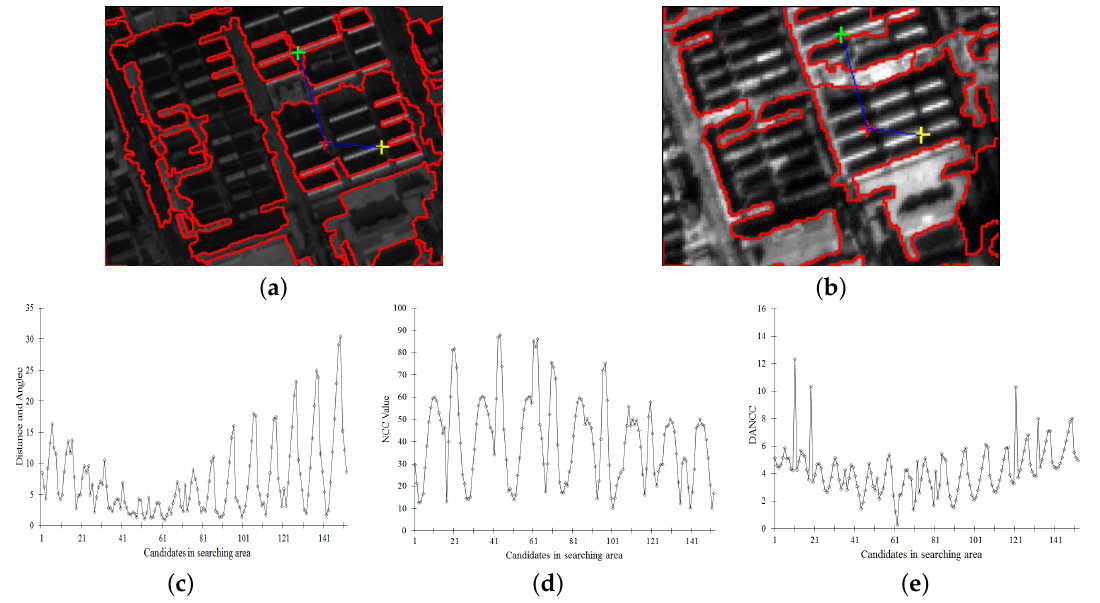
Figure 12. Matching performance comparison with different methods: ( a ) zoomed view of a small part of the left image; the root node is marked in red; a starting node is marked in green; and the remaining point is marked in yellow; ( b ) zoomed view of a small part of right image and the correspondence determined by DANCC is marked in yellow; ( c ) the distribution of similarity values in the searching area using the method presented by Xiong [17,18]; ( d ) the distribution of similarity values in the searching area using NCC; ( e ) the distribution of similarity values in the searching area using DANCC.